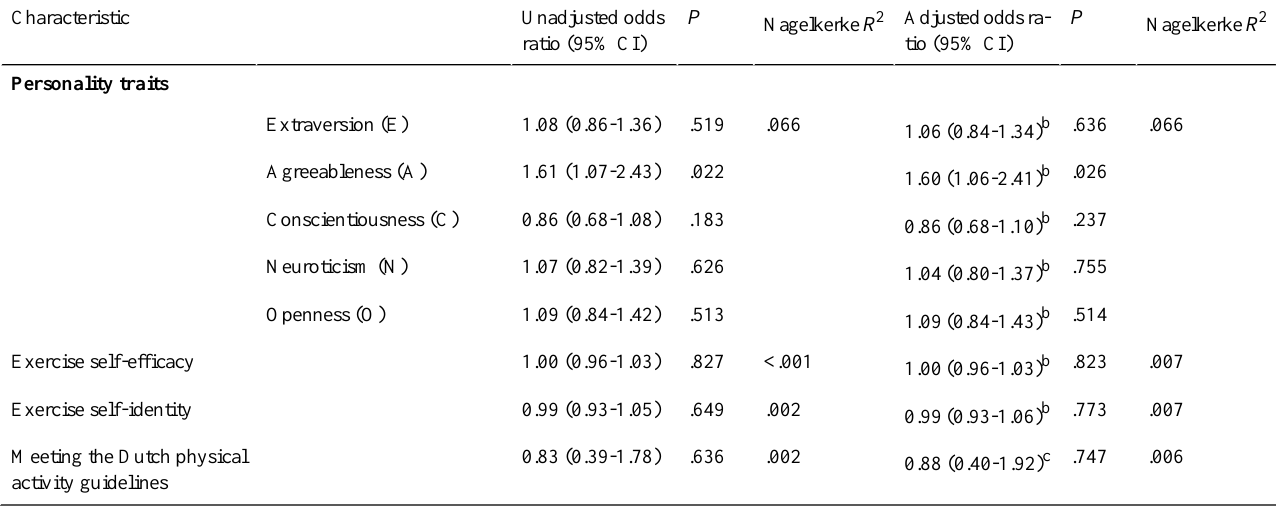
Table 4. Association between personality traits and a high preference for behavior change techniques addressing goal setting and goal reviewing a .